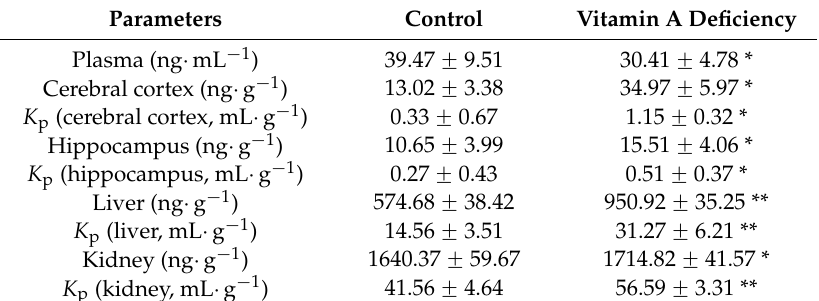
Table 3. Effects of vitamin A deficiency on the vincristine (VCR) distribution in cerebral cortex, hippocampus, liver and